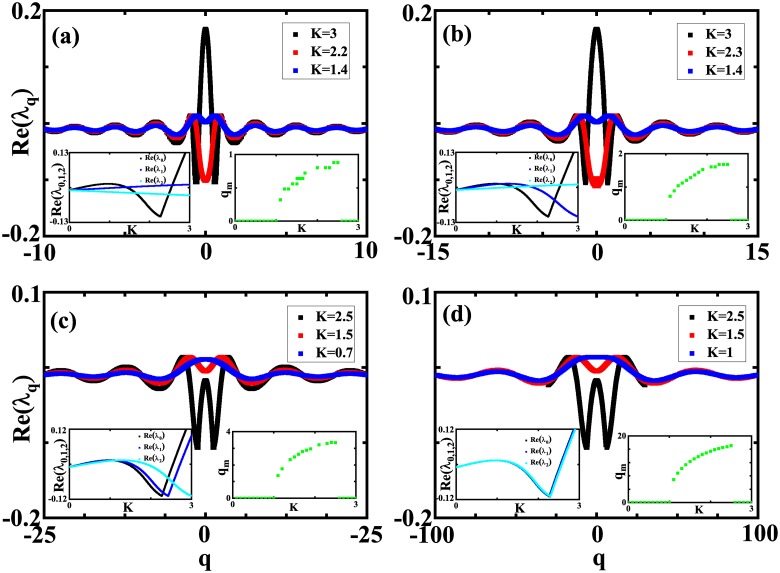
The growth rate λq against q.The growth rate λq obtained from Eq (10) is plotted against real number q for different coupling strength. The left inset in each panel shows Re(λ0), Re(λ1) and Re(λ2) against K, while the right inset shows qm at which Re(λq) reaches its maximum against K. (a) σ = 0.4, (b) σ = 0.2, (c) σ = 0.1, (d) σ = 0.02. γ1 = 1, γ2 = 0.01, α = 0.8, and p = 0.9.